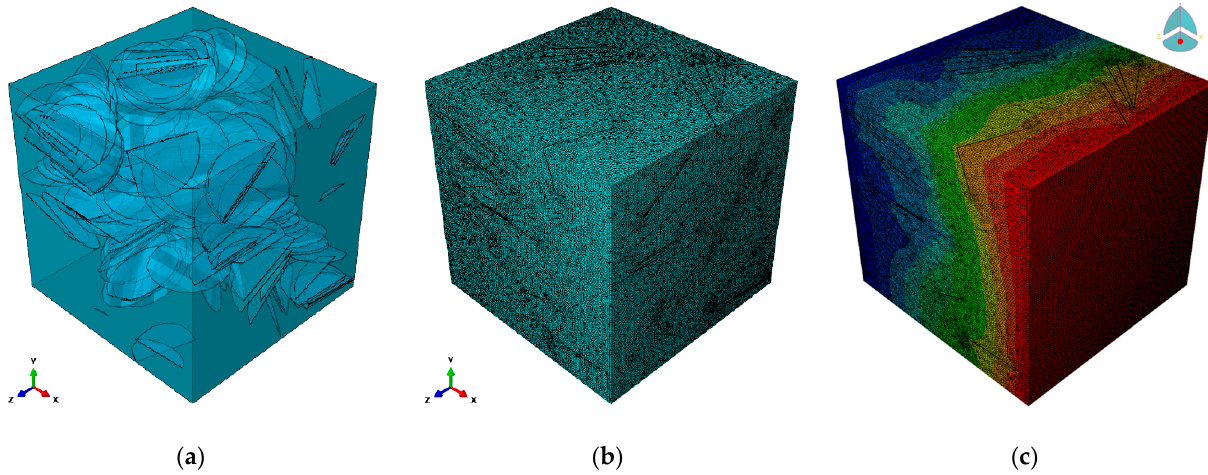
Figure 4. ( a ) An example of composite RVE including 150 flat disks with the aspect ratio 1:100 and 4% of volume concentration. ( b ) The four-node linear tetrahedron shape mesh for the RVE. ( c ) The established steady-state temperature profile created by applying the heat flux passing through the RVE (the color coding from red to blue depicts hot to colder regions, respectively.